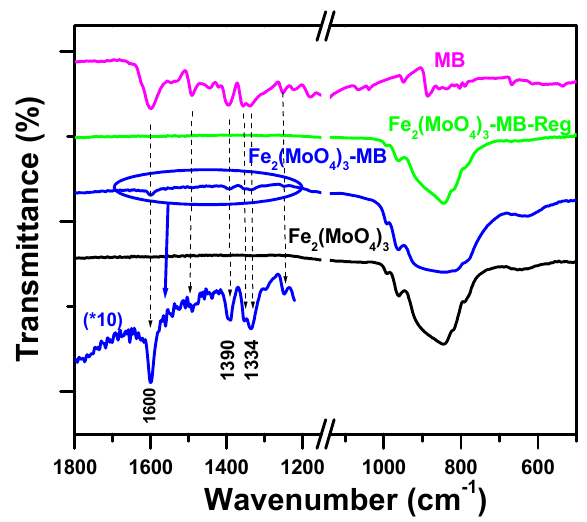
Figure 11. Fourier-transform infrared (FTIR) spectra of Fe 2 (MoO 4 ) 3 , Fe 2 (MoO 4 ) 3 –MB, Fe 2 (MoO 4 ) 3 –MB-Reg and MB.